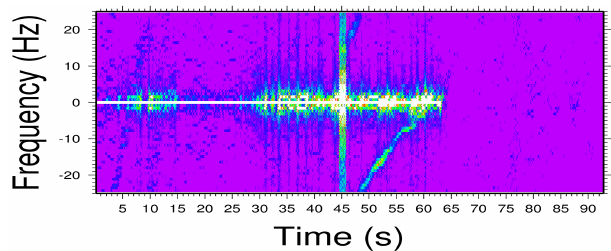
Figure 2. Example radiohologram of setting COSMIC occultation C001.2011.219.10.43.G15, which presents a reflection. The main signal has been nearly stopped by beating it against a filtered refer- ence. Both components have a narrow spectral width, but the sup- plementary tone also shows aliasing (at 46–48s, + 20Hz). Both tones eventually merge. This final section, where the low tropo- sphere is being scanned, shows spectral broadening in both the di- rect and reflected